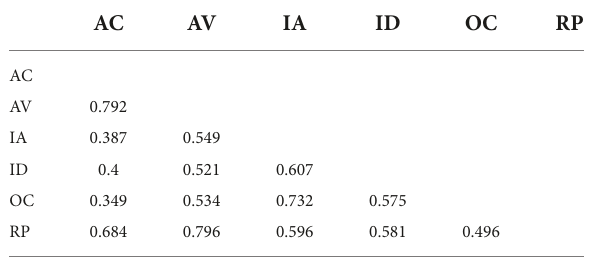
TABLE 3 Heterotrait–MONOTRAIT RATIO